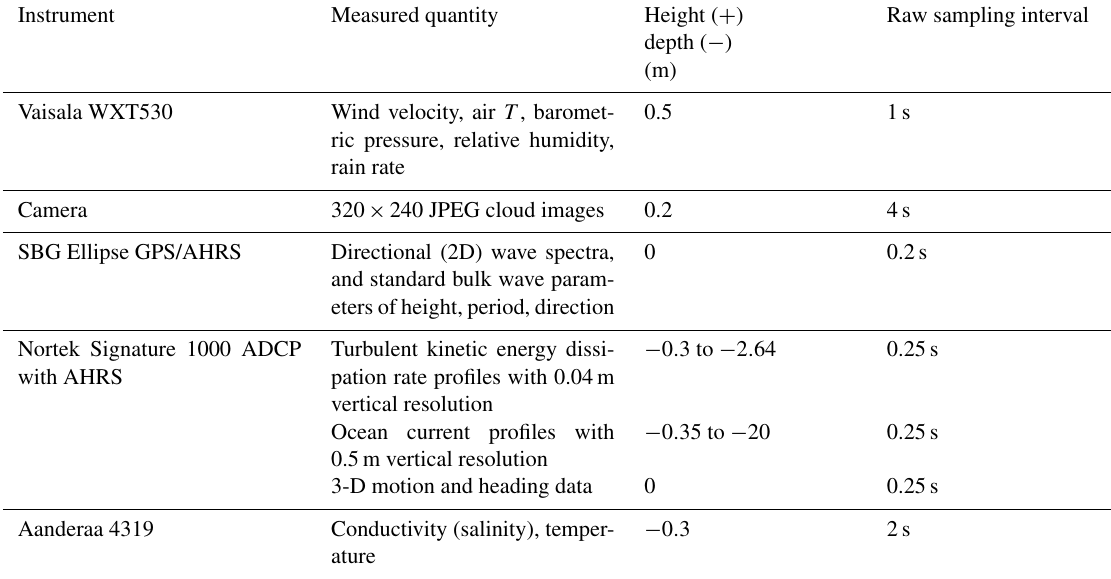
Table 8. Instrumentation on board the v4 SWIFTs (serial numbers 22, 23, 24, 25) for the measurement of atmospheric and seawater parame- ters. Measurements were collected during 8min bursts at the beginning of each hour. Final data products are 8min averages of high-resolution raw data, time-stamped at the beginning of each hour.